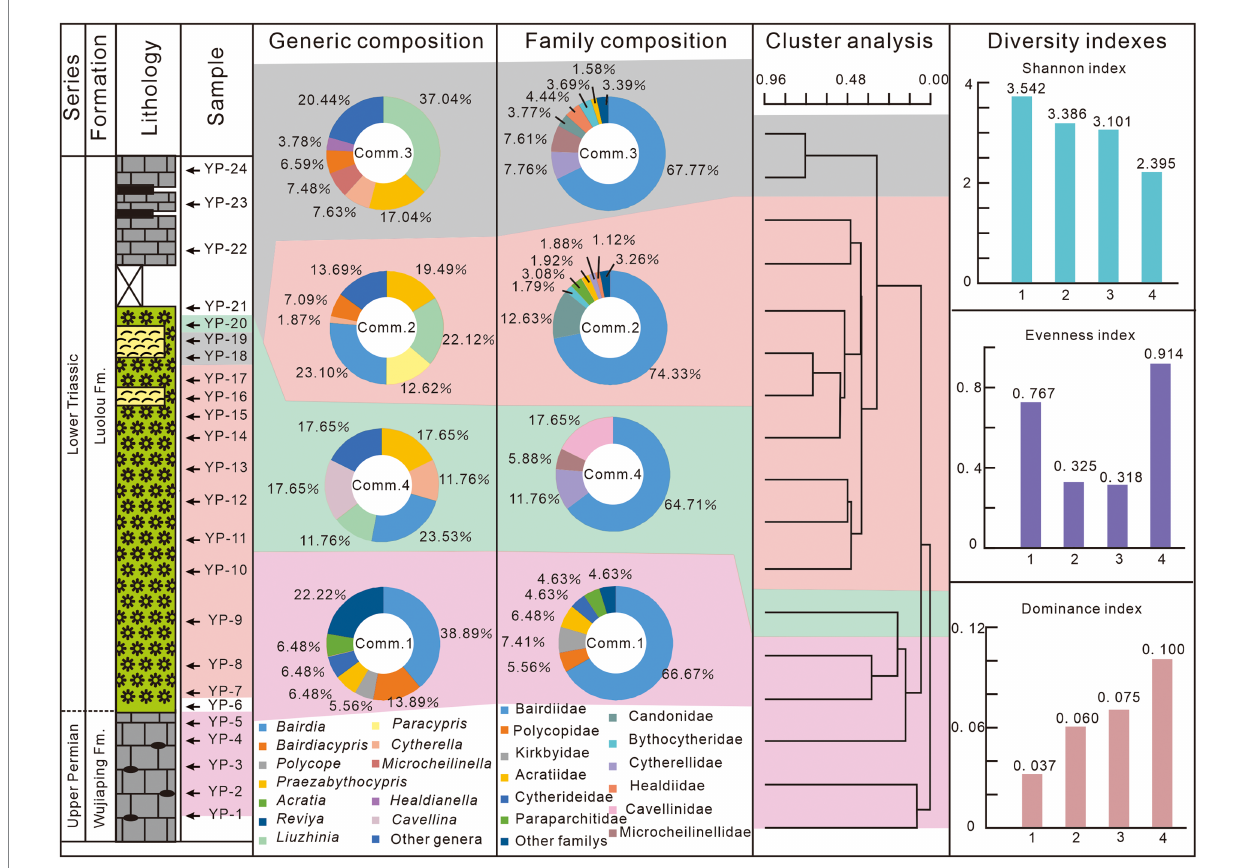
FIGURE 7 Ostracod communities based on cluster analysis, and their diversity indexes from the Youping section. Comm: Community.